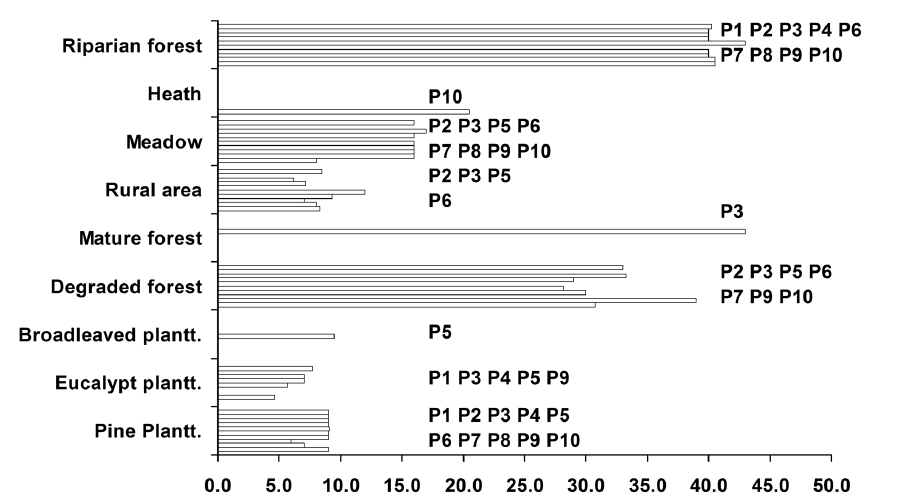
Figure 2. Bar plot of biological value index for each vegetation unit inspected at the Golako river basin.